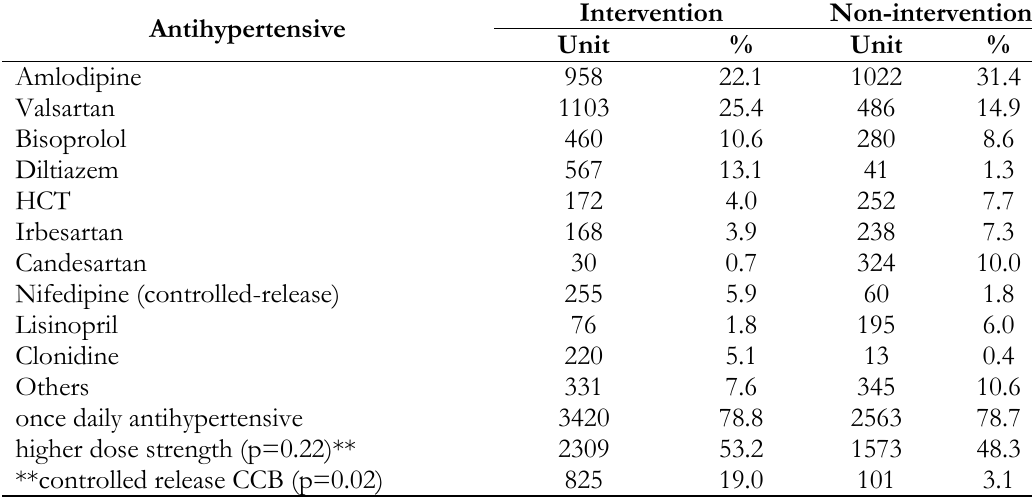
Table II. Profile and proportion of the antihypertensive medicine between intervention and non- intervention